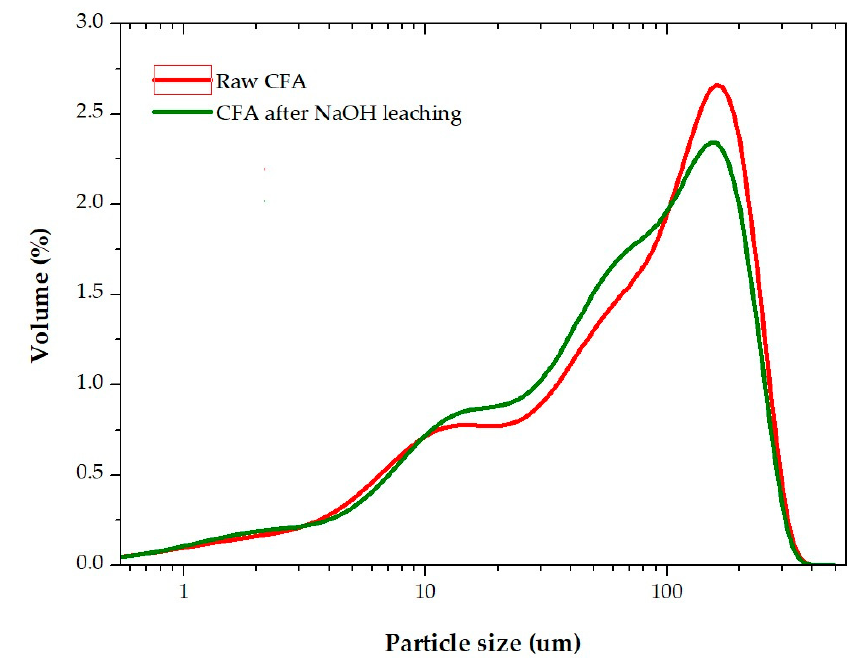
Figure 1. The particle size distribution of the raw coal fly ash (CFA) and CFA after NaOH leaching at T = 110 ◦ C, liquid to solid (L / S) ratio = 21.5, τ = 75 min. Table 1. Chemical composition of the CFA from Reftinskaya thermal power plant (TPP), Asbest, Russia. Main Components, wt.%